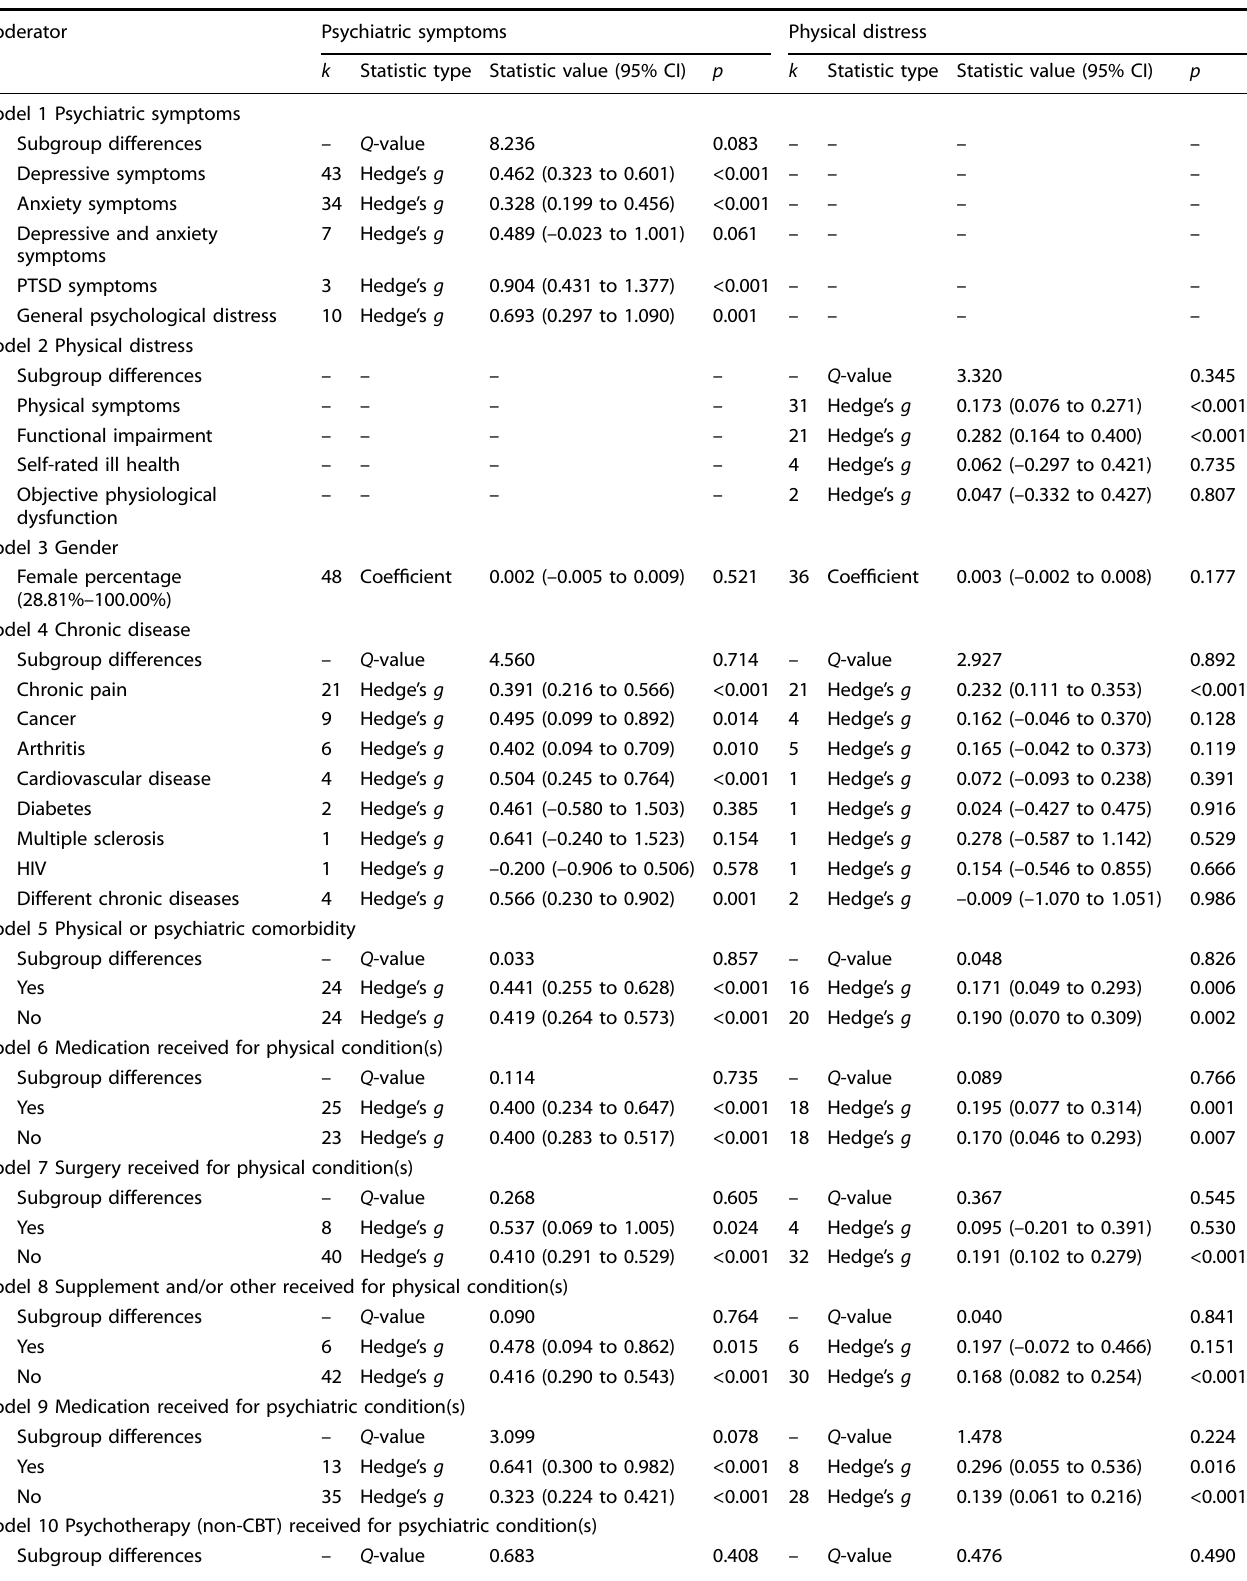
Table 3. Moderators of the effectiveness of IM-CBT on psychiatric symptoms and physical distress ( n = 44